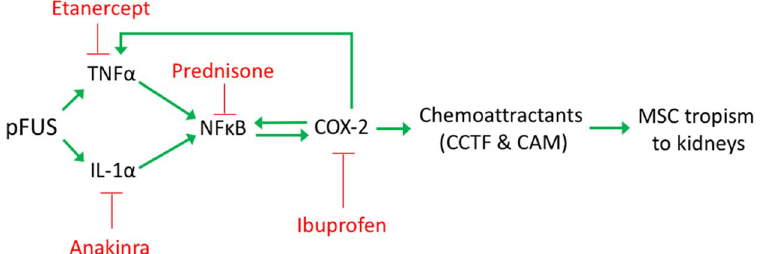
Figure 6. Schematic of pFUS-induced molecular response. Stimulation in the pathway is shown by a green arrows and inhibition by a red “T”. Blocking any particular point with a drug blunts the expression of chemoattractants and MSC